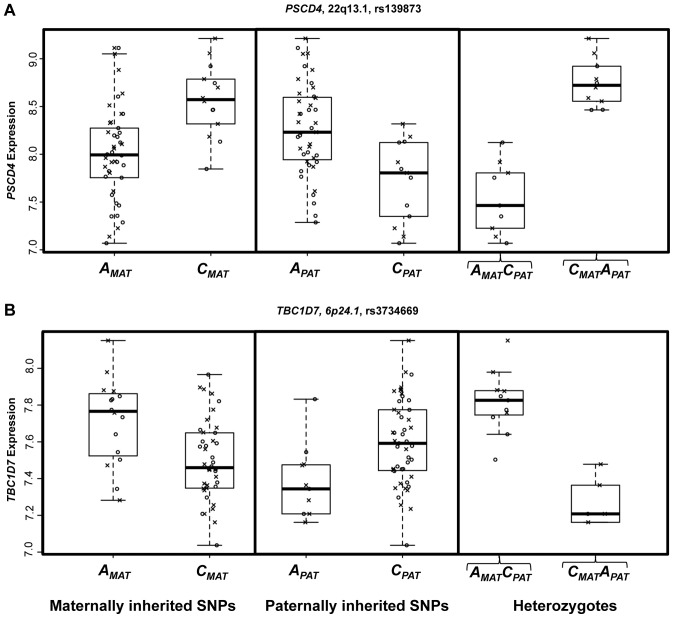
The two most significant SNP-gene pairs identified using the Likelihood Ratio Test.Results for (A) PSCD4 and (B) TBC1D7. In each plot the three panels show variation of gene expression with respect to maternally inherited SNPs, paternally inherited SNPs and two classes of heterozygotes, respectively. Box plots show the distributions of gene expression for CEU (circles) and YRI offspring (crosses) with respect to maternally (MAT) and paternally (PAT) inherited SNPs. Note that unlike loci identified using separate association with maternal and paternal alleles where a difference in gene expression level is seen for only one of the two parental alleles, for both genes the A and C alleles have opposite effects on gene expression when inherited maternally versus paternally.